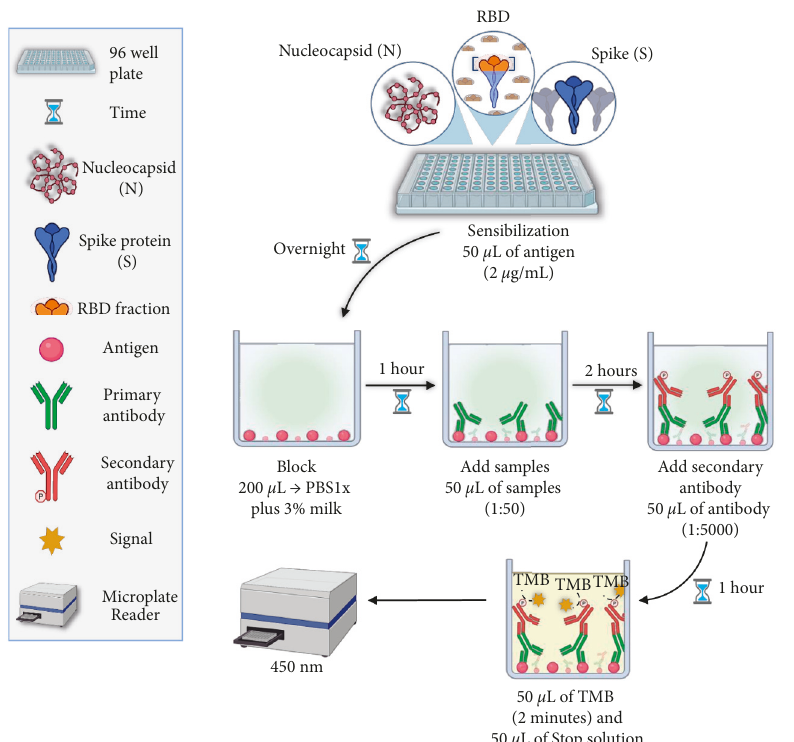
Figure 1: Flowchart of the in-house ELISAs developed. ELISA plates were coated with 50 μ L of the different antigens (N, S, or RBD fraction) at 2 µ g/mL. After 16 hours, the plates were washed with PBS and blocked with a solution of PBS containing 3% non-fat milk and 0.05% Tween 20 for 1 hour. Next, the serum samples were diluted 1:50 in PBS containing 1% nonfat milk and 0.05% Tween 20 and added to plates coated with SARS-CoV-2 antigens. Following 2 hours of incubation, the plates were washed and incubated with horseradish peroxidase- labeled anti-human IgG secondary antibody (1: 5000 dilution in PBS containing 1% nonfat milk and 0.05% Tween 20). The plates were then washed following 60min incubation at 37 ° C, and 3,3 ′ ,5,5 ′ -tetramethylbenzidine substrate was added. Two min later, stop buffer was added, and the absorbance values were measured at 450nm wavelength using a microplate